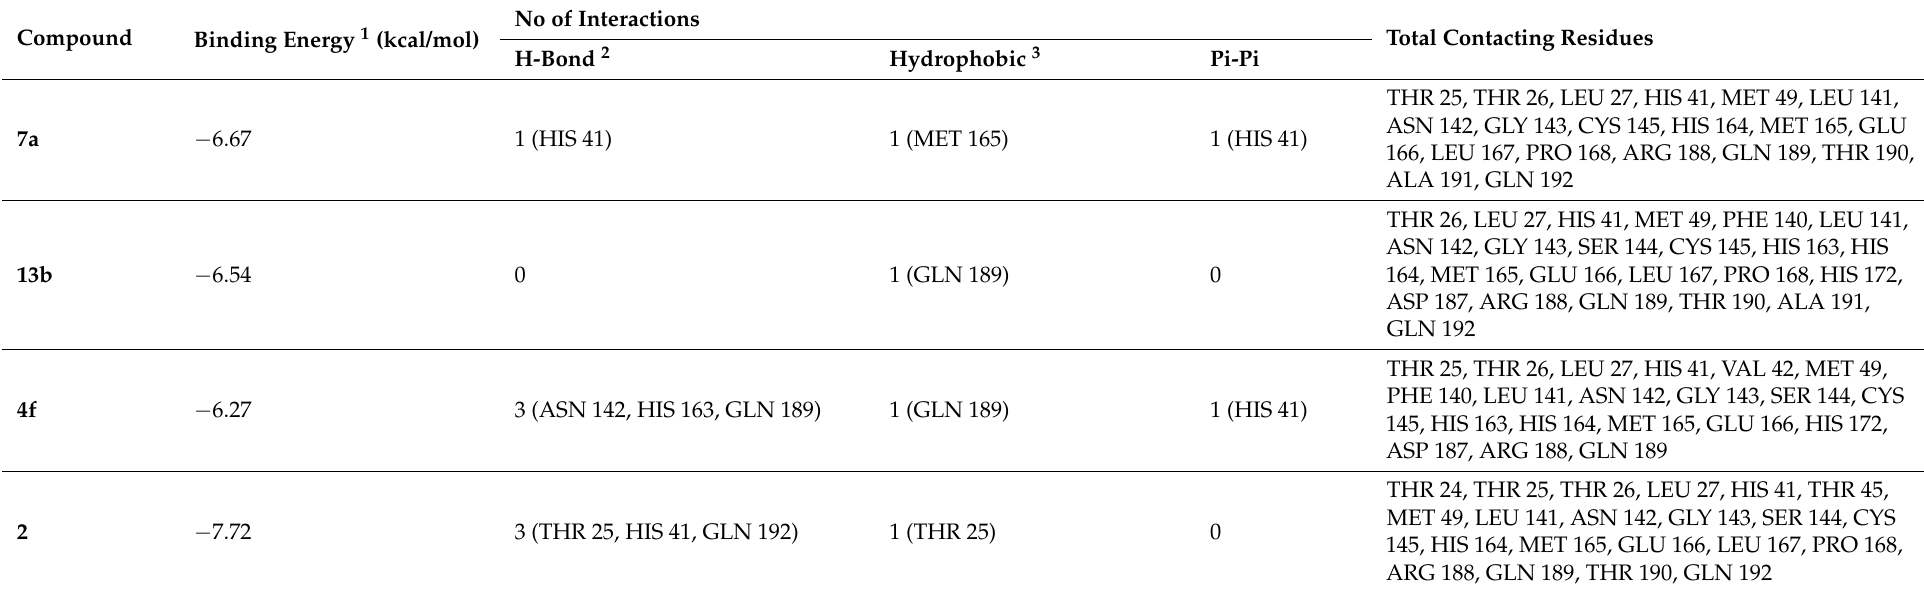
Table 4. Molecular docking simulation results for the chemically synthesized derivatives of